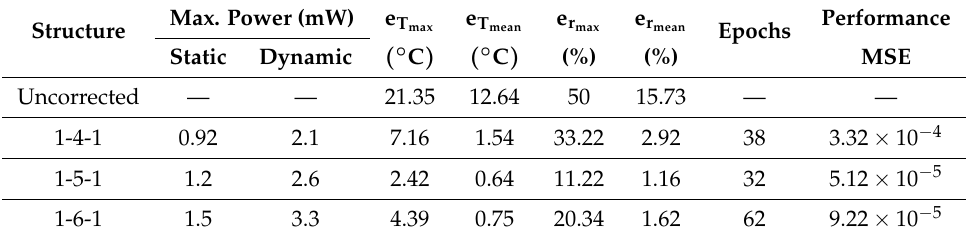
Table 2. Comparative summary of the three ANN structures for the non-linear characteristic NL1 .